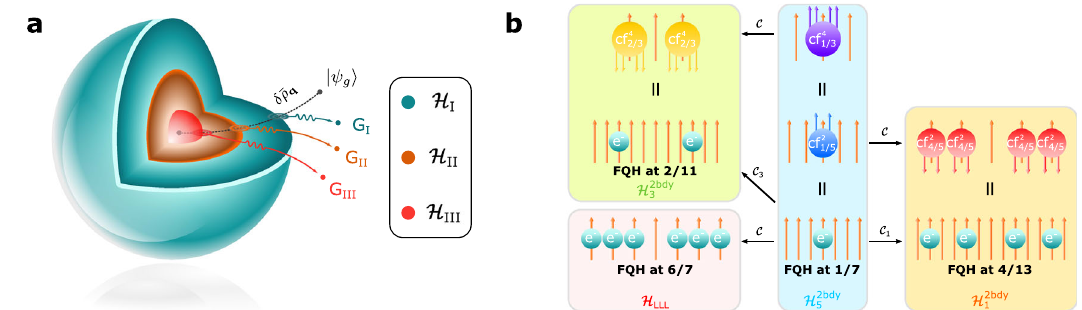
Fig.2|Multiplegravitonmodesandcompositefermionization.a Anillustration ofthehierarchicalstructureofthreeCHSsandthegroundstate ∣ ψ 0 sphere) in the Hilbert space. The corresponding GMP mode ∣ ψ g i is outside H I so one can imagine the regularized guiding center density operator acting on the ground state goes through three CHSs, leading to three emergent GMs because of the fl uctuation around the metric of each of the CHSs. b PH conjugate of